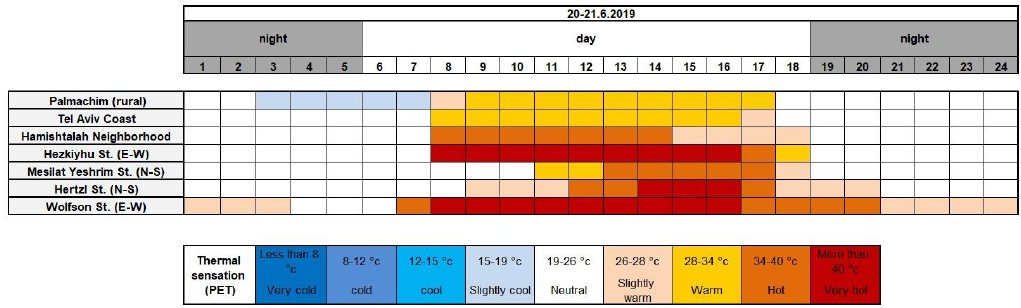
Figure 9. Hourly physiological equivalent temperature (PET) values in and around selected stations in Tel Aviv on20 June 2019.